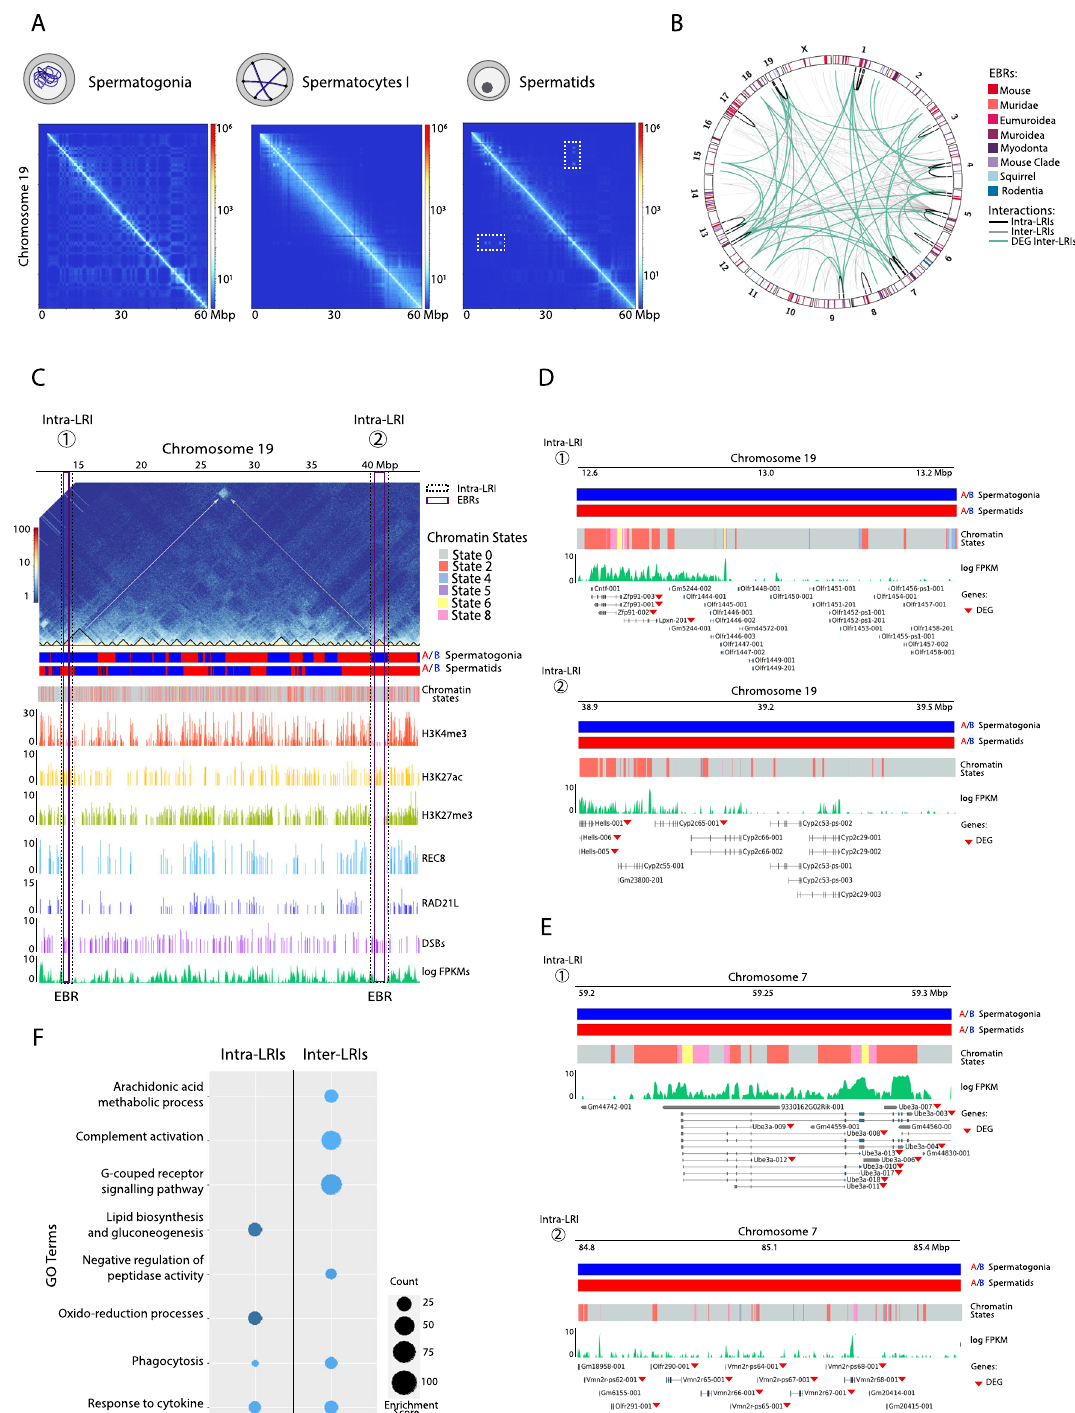
accessible as meiosis progresses, especially in post-meiotic stages of spermatogenesis (i.e., round spermatids), and which are susceptible to DNA damage. Importantly, we also reveal the presence of post-meiotic cell speci fi c long-range interactions, which not only recapitulate evolutionary syntenic associations present in the Muridae ancestor leading to fi ssions in mouse, but also ancestral chromosome fusions that created new mouse chromosomes.